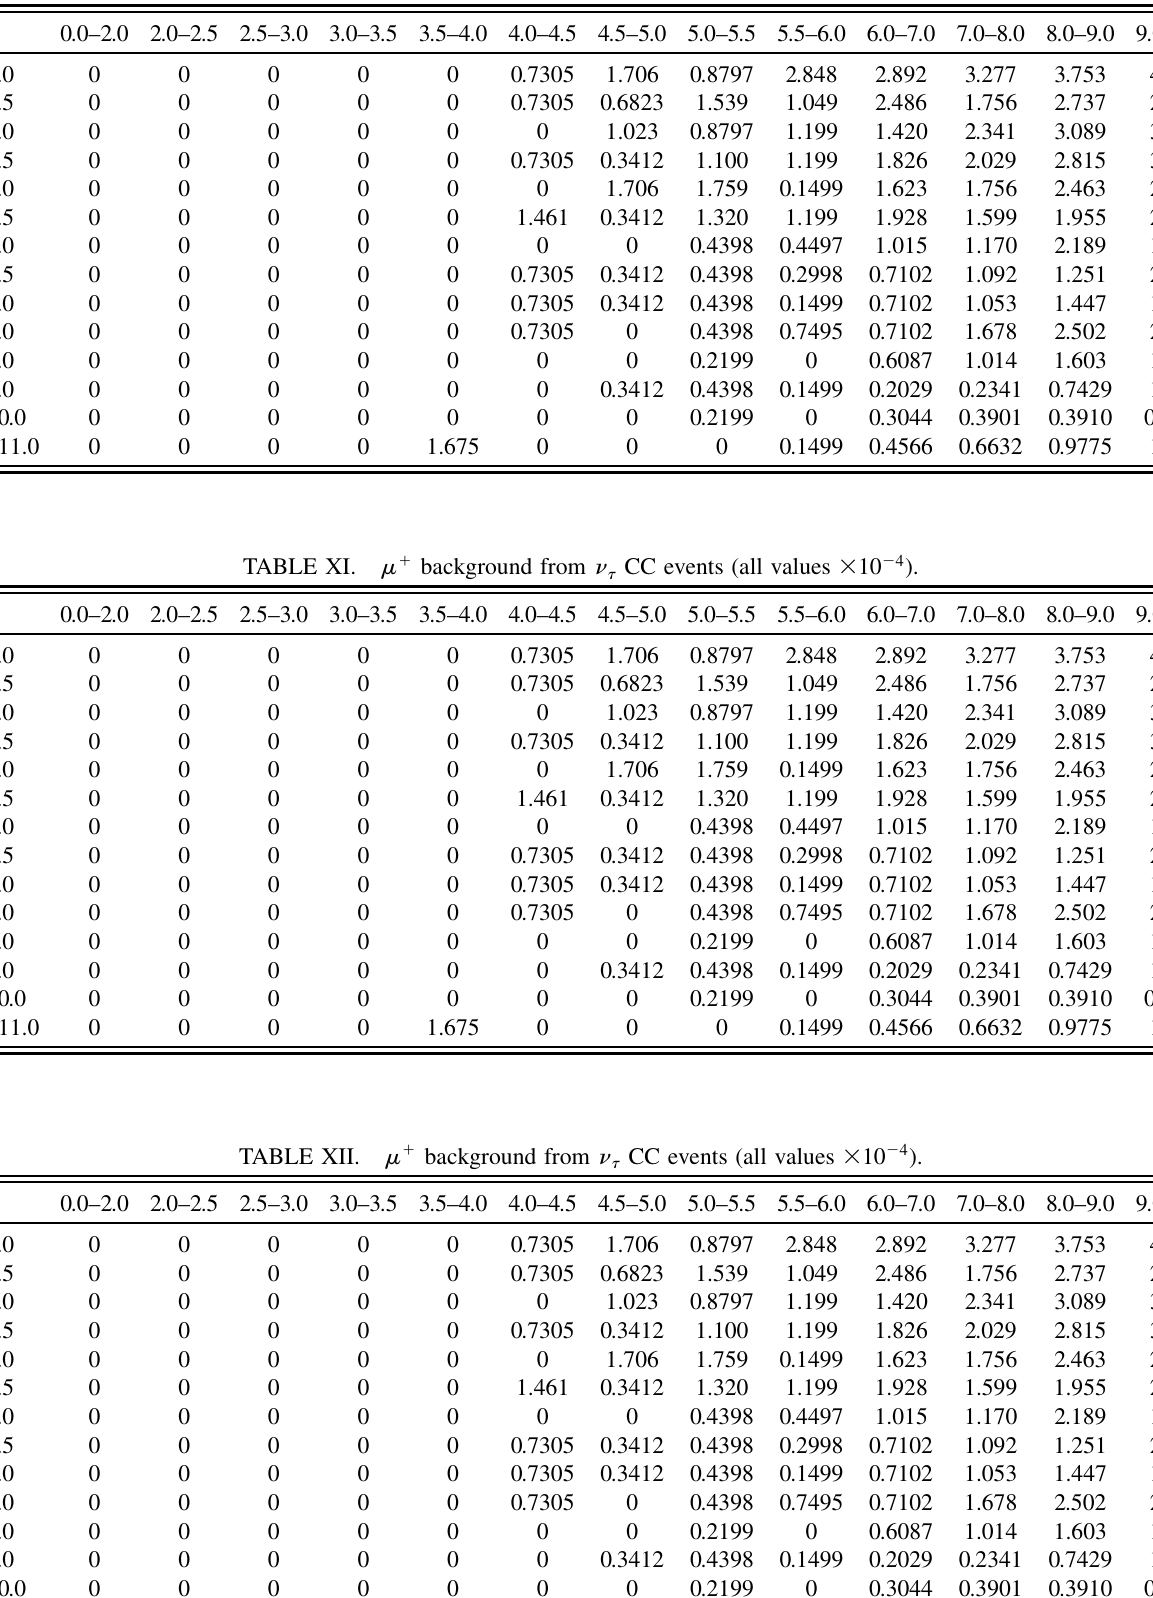
TABLE X. (cid:4) þ background from (cid:3) (cid:5) CC events (all values (cid:2) 10 (cid:1) 4 ).